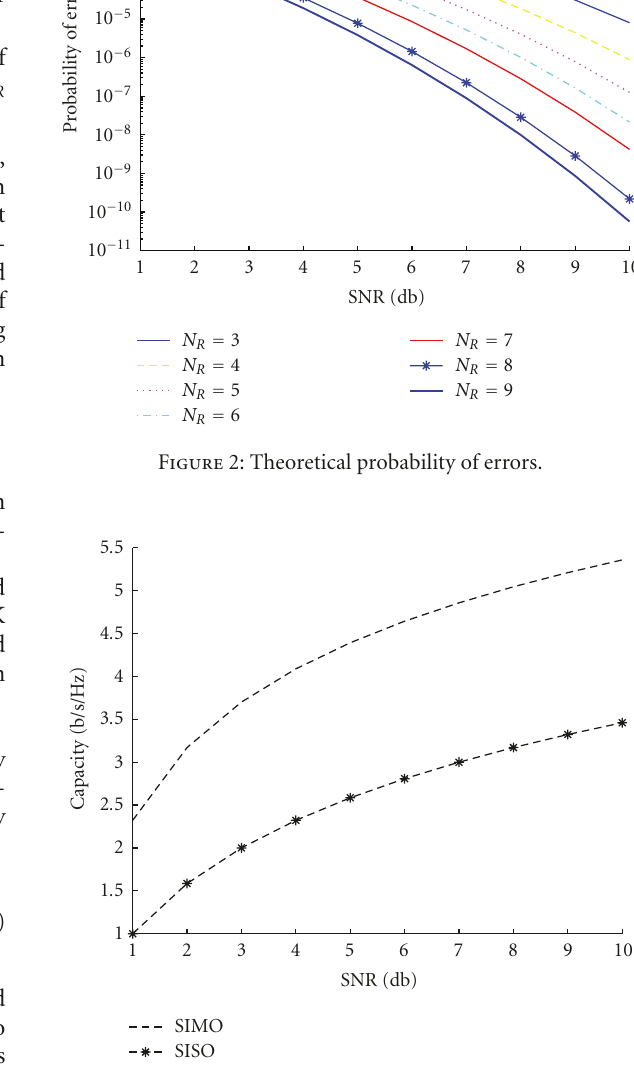
Figure 3: Variation of capacity C with respect to SNR. Upper curve describes SIMO and lower one is for